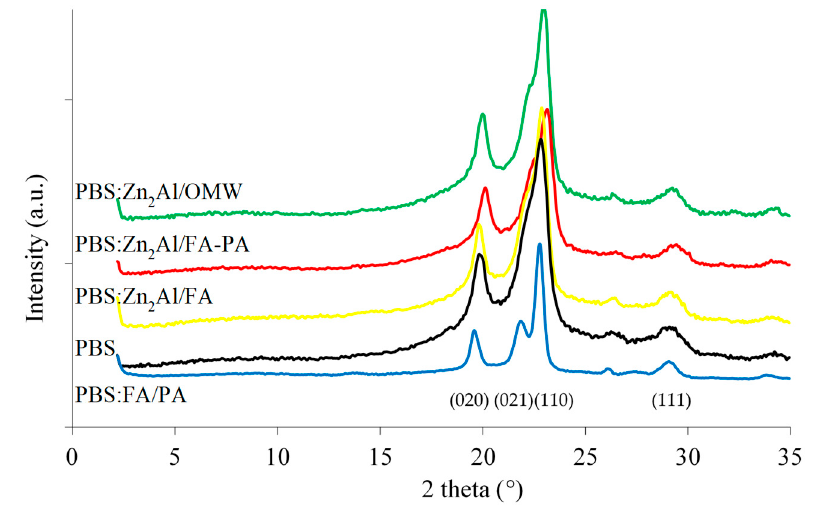
Figure 1. XRD profiles of PBS and some PBS:Zn 2 Al / X composites with indexing of the main reflections due to the crystalline structure of PBS.